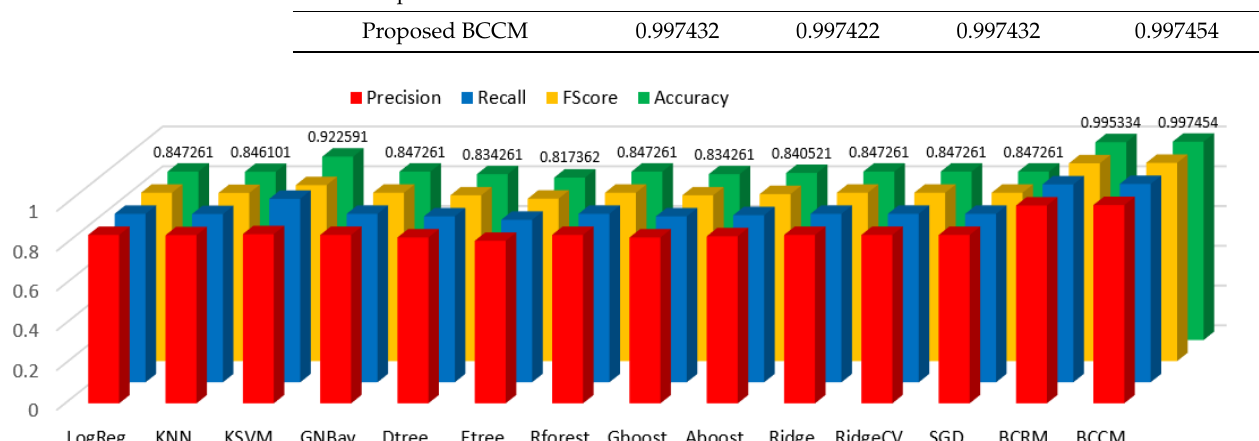
Figure 11. Performance of Proposed BCRM and BCCM with existing classifiers.